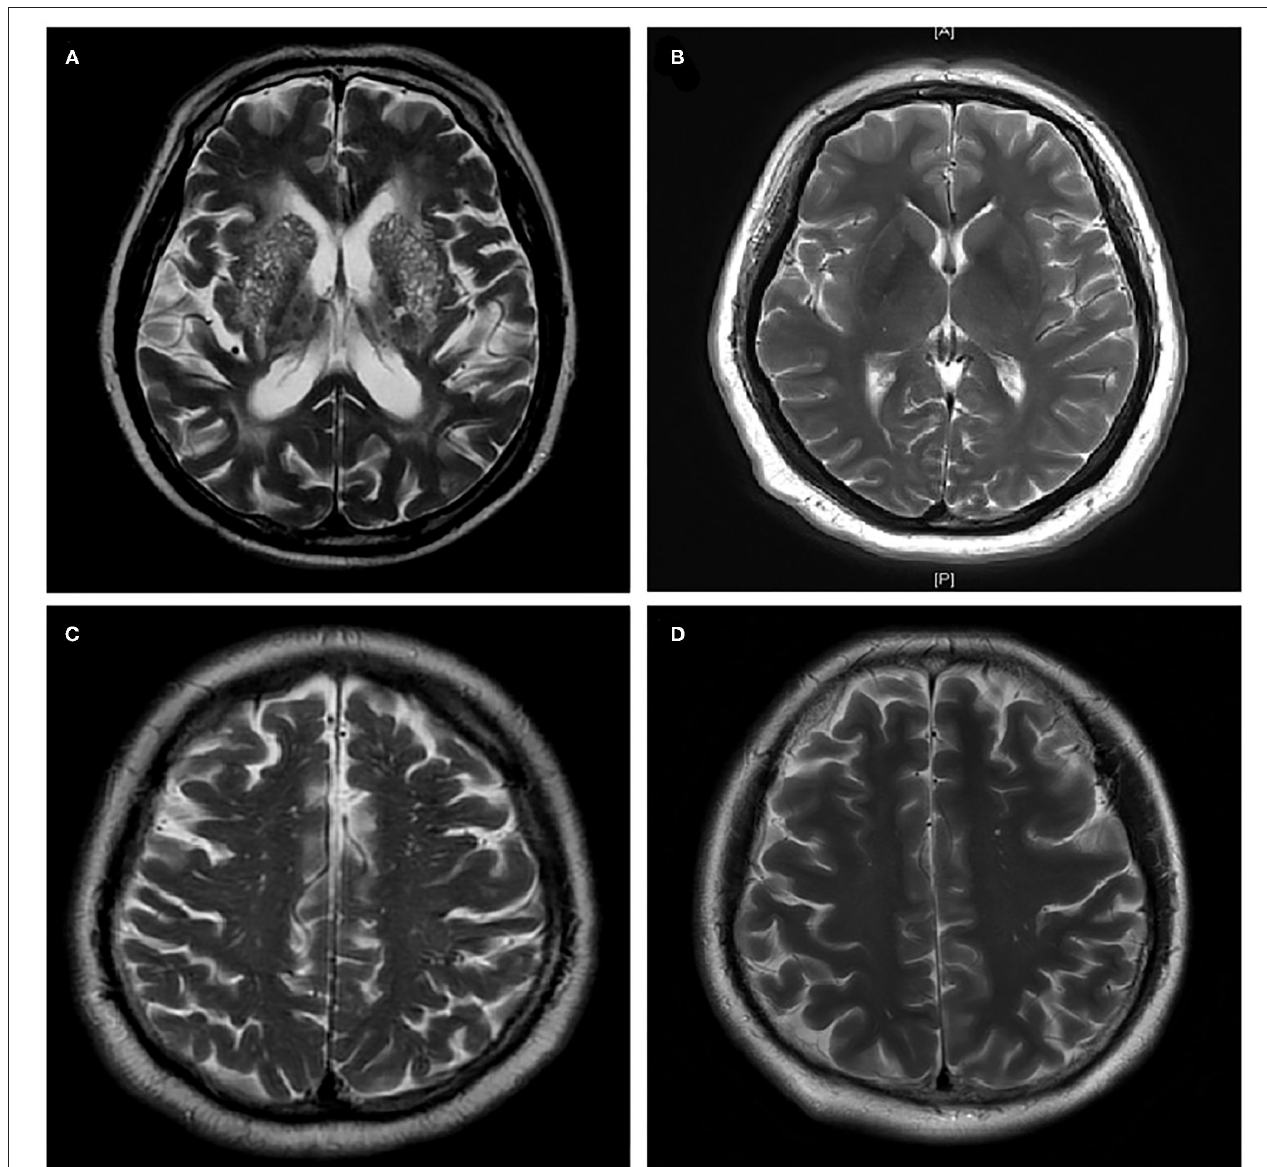
FIGURE 2 | Enlarged perivascular spaces group and control group. (A) Enlarged perivascular spaces in basal ganglia (BG-EPVS) group (Patients with EPVS > 10 on one side of the basal ganglia slice containing the maximum amount); (B) control group for BG-EPVS (Patients with EPVS < 10 on one side of the basal ganglia slice containing the maximum amount); (C) enlarged perivascular spaces in white matter (WM-EPVS) group (Patients with EPVS > 10 on one side of the white matter slice containing the maximum amount); (D) control group for WM-EPVS (Patients with EPVS < 10 on one side of the white matter slice containing the maximum